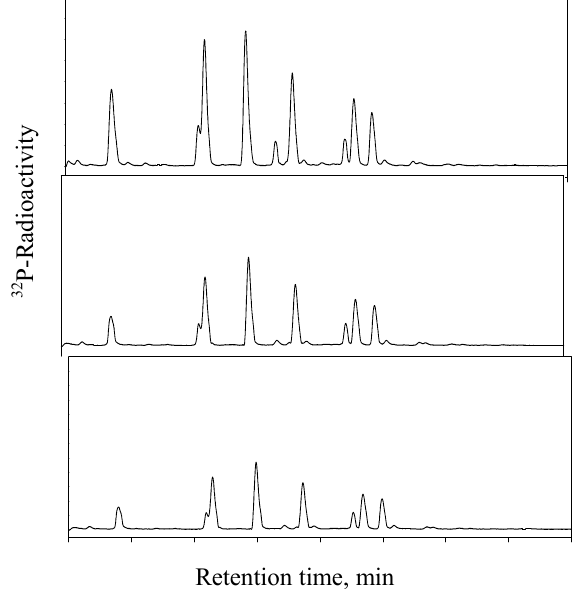
Figure 2: 32 P-Postlabeling/HPLC analysis of DHP- derived DNA adducts formed from (A) DHP-modified calf thymus DNA, (B) calf thymus DNA incubated with the in vitro metabolism of retrorsine, and (C) liver DNA of